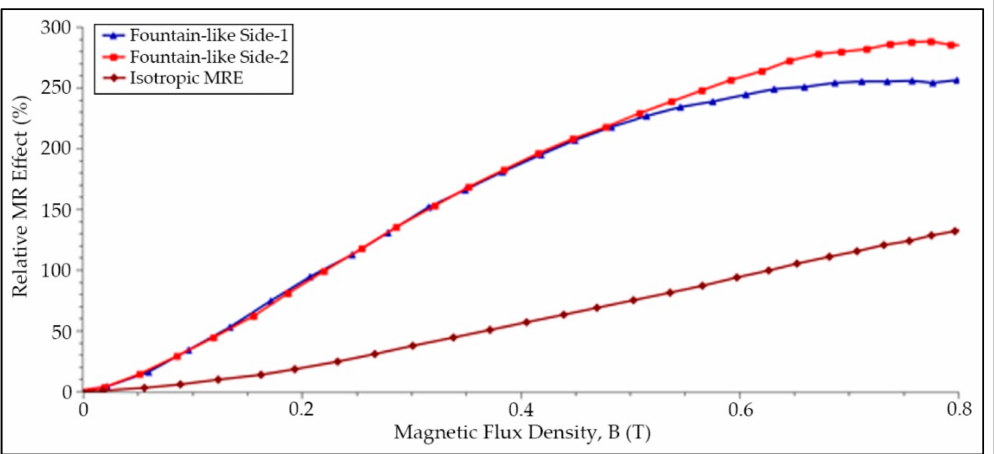
Figure 10. Relative MR Effect of each MRE